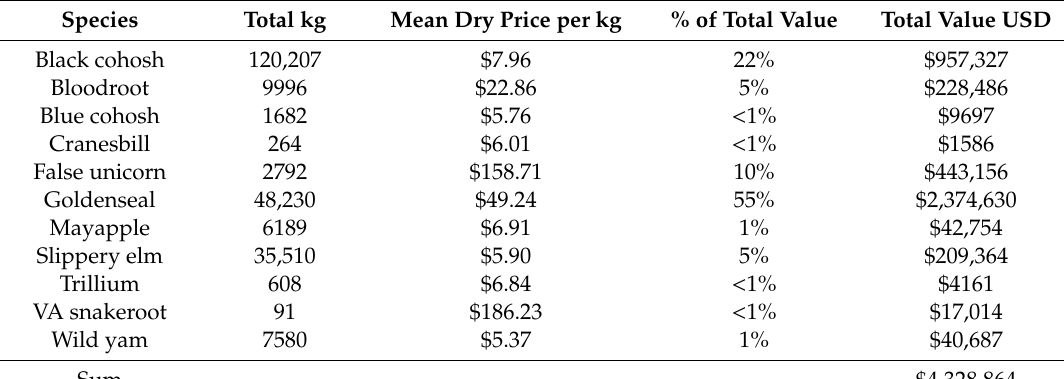
Table 9. Total mean annual estimated value in United States dollars (USD) paid to o ff -root harvesters by ginseng buyers licensed in 15 states in the eastern US study area. Total value is based on mean prices reported by buyers, and by total volumetric sales projected for o ff -root material bought in 2014–2015 in the study